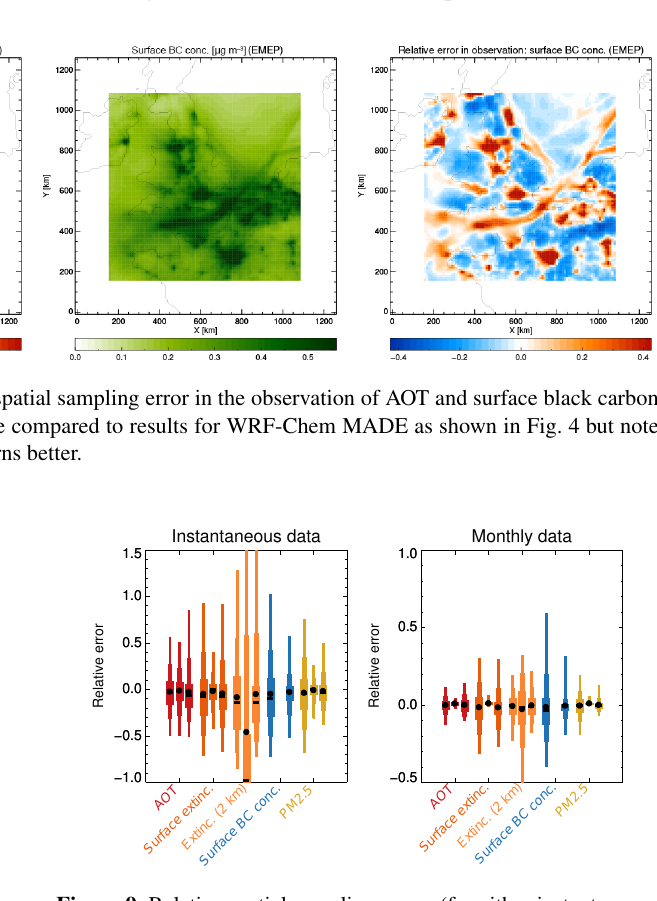
Figure 9. Relative spatial sampling errors (for either instantaneous or monthly data, note the different vertical axes) for three regions simulated with bulk mass schemes (left bar: Europe; middle bar: Ocean; right bar: Japan). Black carbon concentrations over the ocean are zero and so are related spatial sampling errors. Further explanation in Sect.